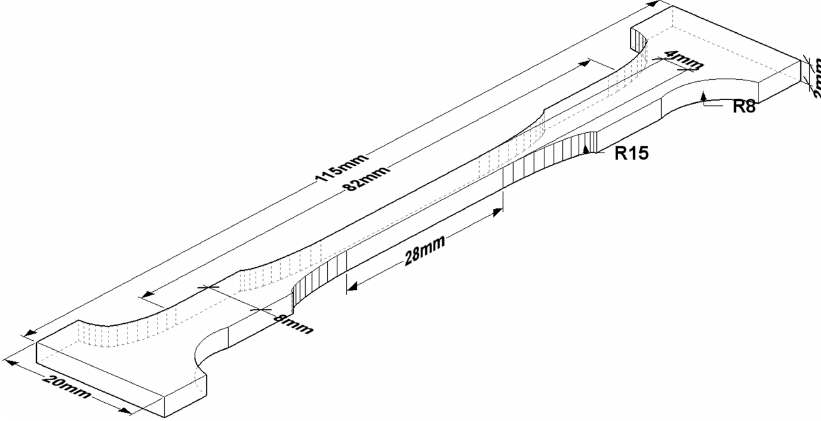
Figure 2: Dimensions of the tensile test